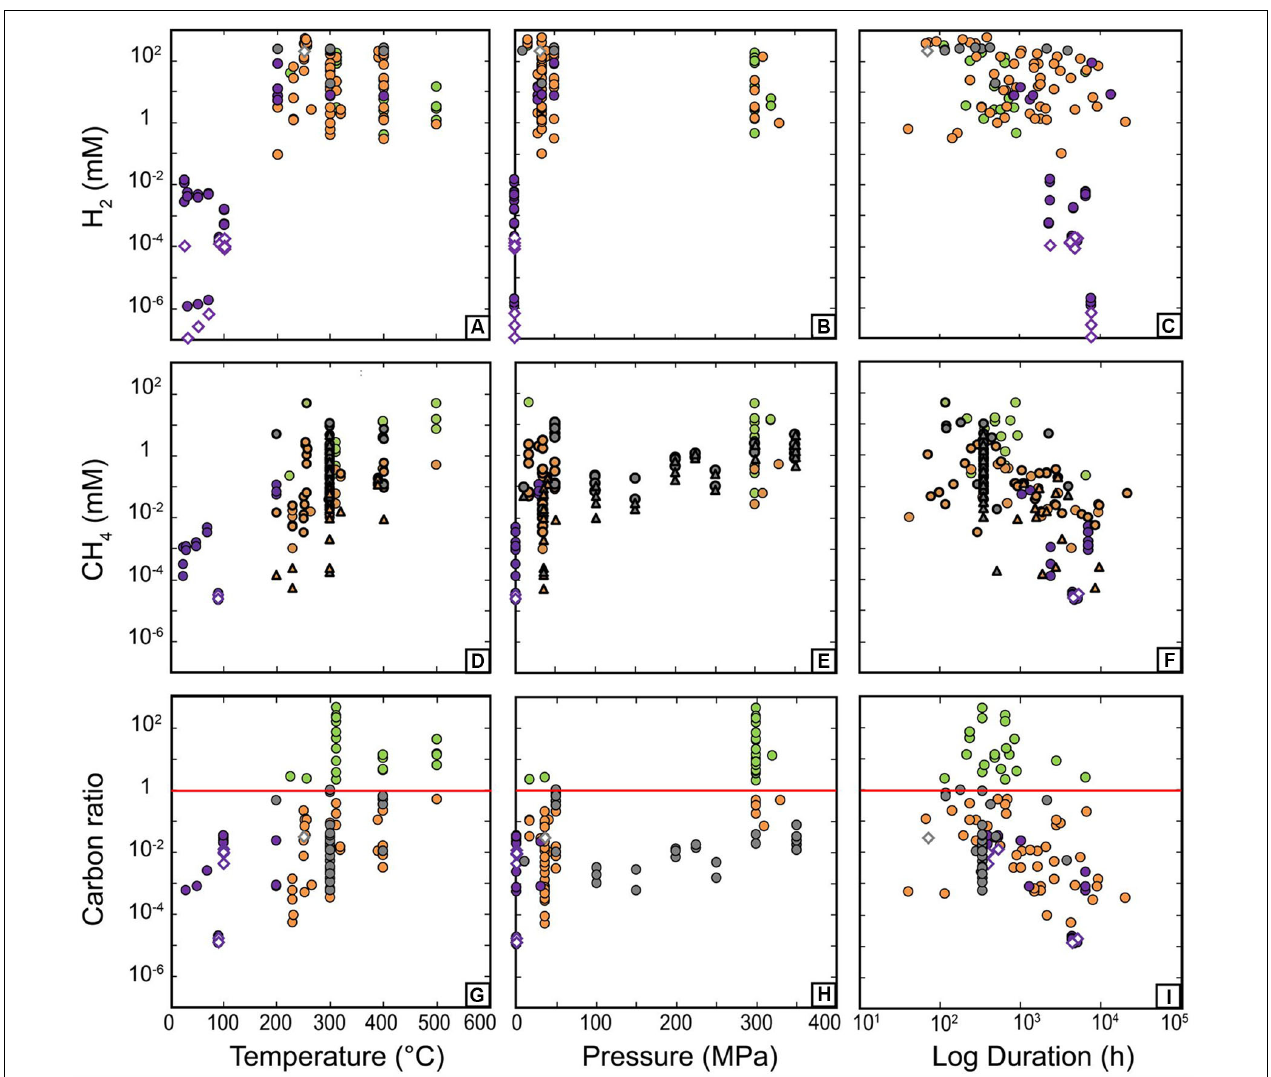
FIGURE 8 | Concentrations of H 2 (A–C) , CH 4 (D–F) , and carbon conversion (G–I) displayed as a function of temperature (A,D,G) , pressure (B,E,H) , and experiment duration (C,F,I) . Diamond symbols correspond to “blank experiments” run without minerals in the experimental load. Thick triangle symbols in (D–F) highlight 13 CH 4 concentration while thick circles show the corresponding total CH 4 also including 12 CH 4 . In (G,H) , the red line corresponds to a carbon ratio value of 1, beyond which is suspected to be contaminated. Color coding consistent with Figure 5